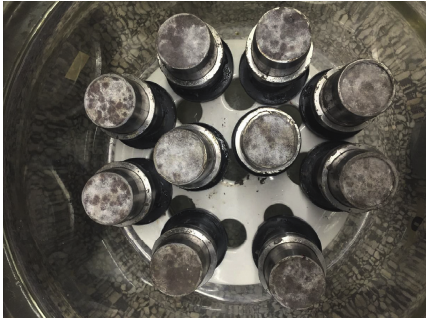
Figure 4: Soft clay specimens in the moisture cylinder after curing for 28